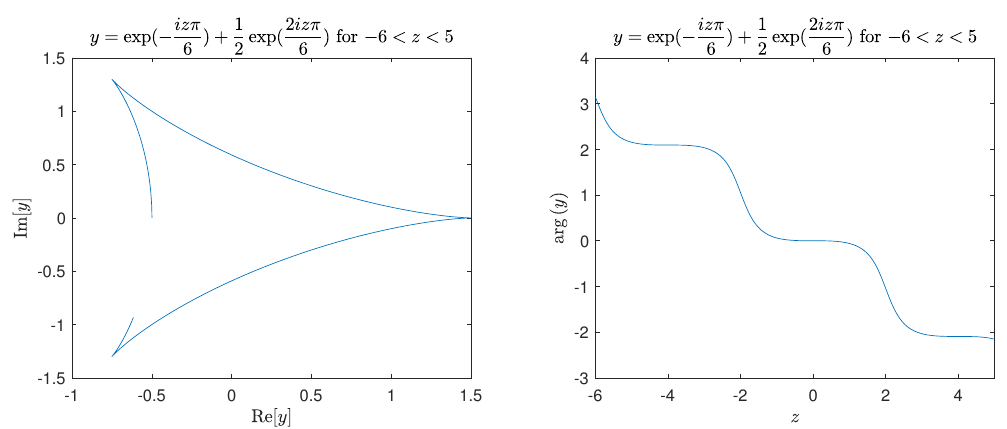
Figure 27 . f abs as a function of temperature.